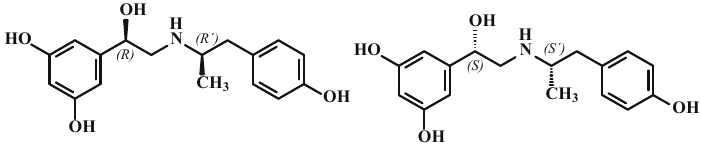
Figure 4: Chemical structures of more active isomers of fenoterol.